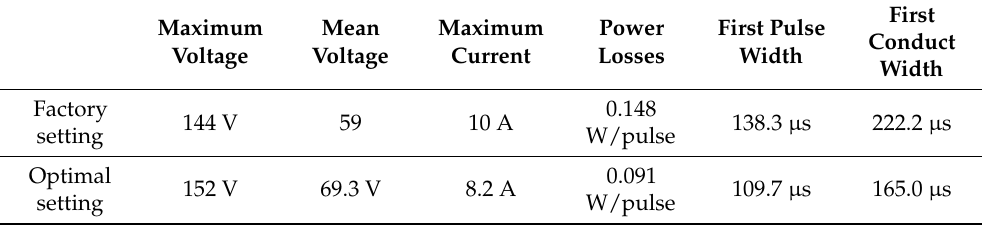
Table 5. Comparison of factory settings and Taguchi-Regression algorithm for the fuel injection test.